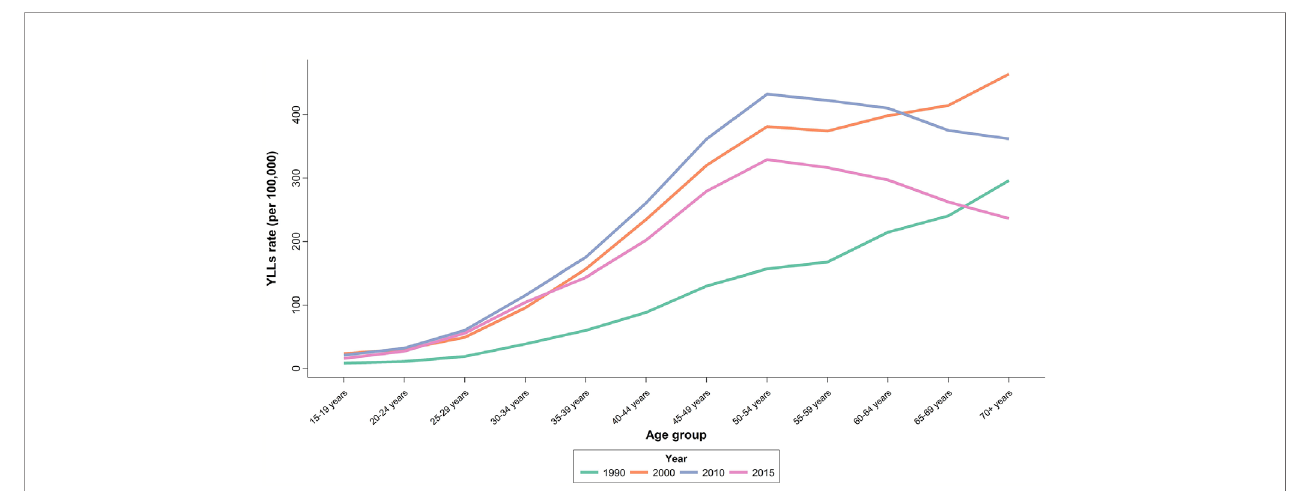
FIGURE 4 | National age trend of YLL in 1990, 2000, 2010, and